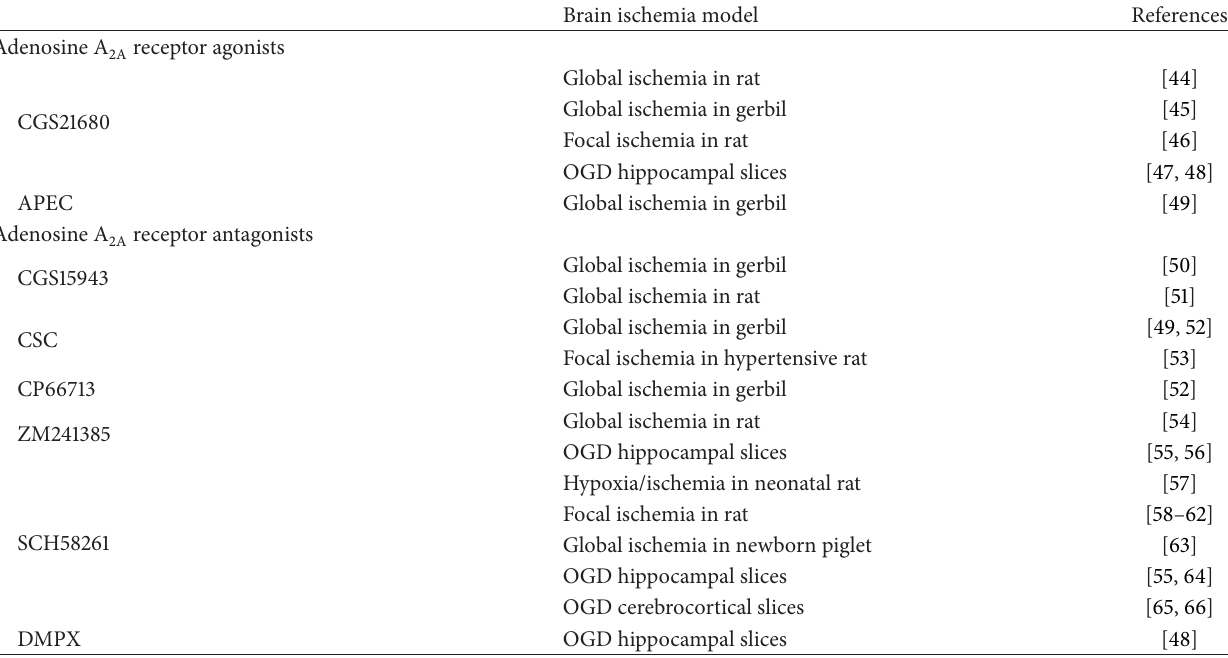
Table 1: Adenosine A 2A receptor ligands used in brain ischemia “in vivo” and “in vitro” models. Brain ischemia